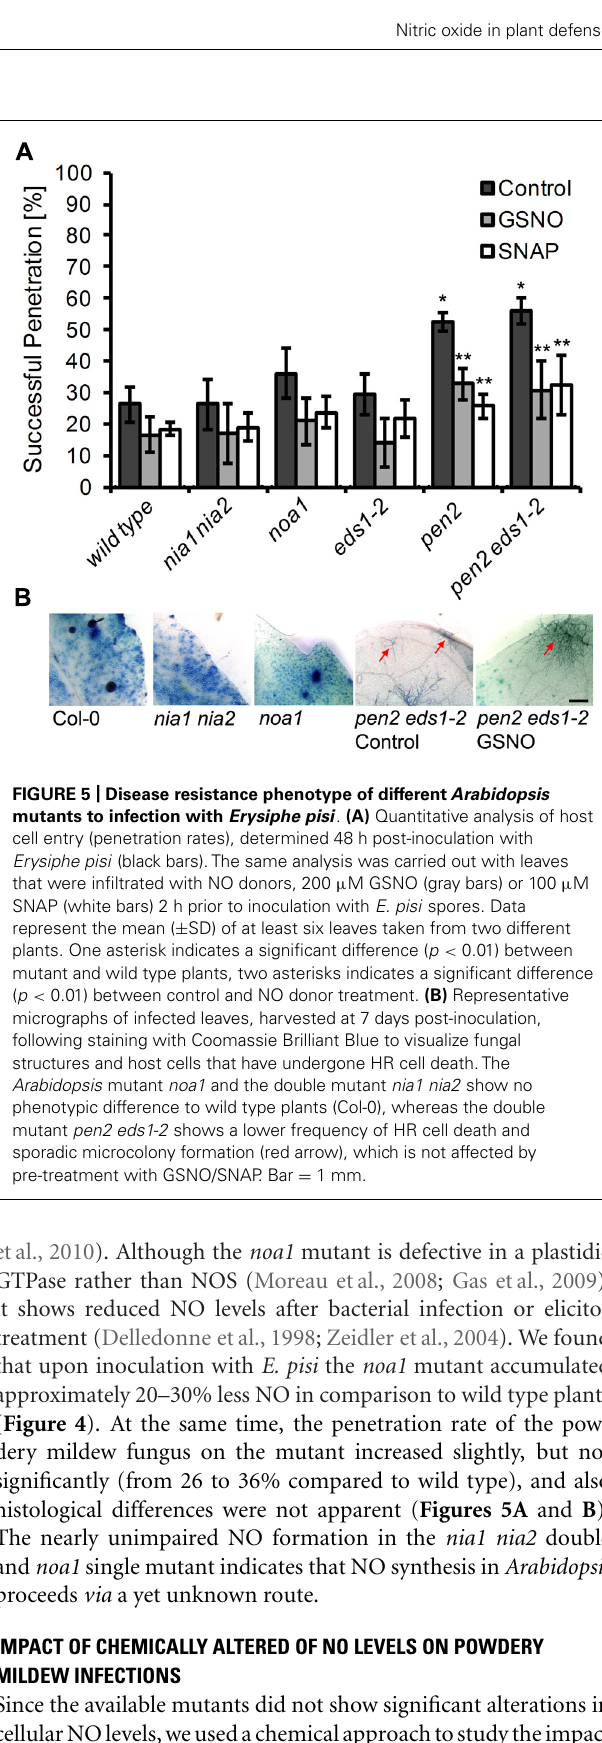
FIGURE 4 | NO formation in Arabidopsis mutants defective in putative NO synthesis pathways. Leaves of different Arabidopsis thaliana genotypes, Col-0 (red), nia1 nia2 (purple), noa1 (blue), were inoculated with the non-adapted powdery mildew Erysiphe pisi and harvested at the indicated times for quantification of NO formation by integration of DAF-FM T fluorescence at infection sites. (For experimental details see legend to Figure 1 ).Values represent the mean ( ± SD) of 20 infection sites taken from four different leaves of two different plants.